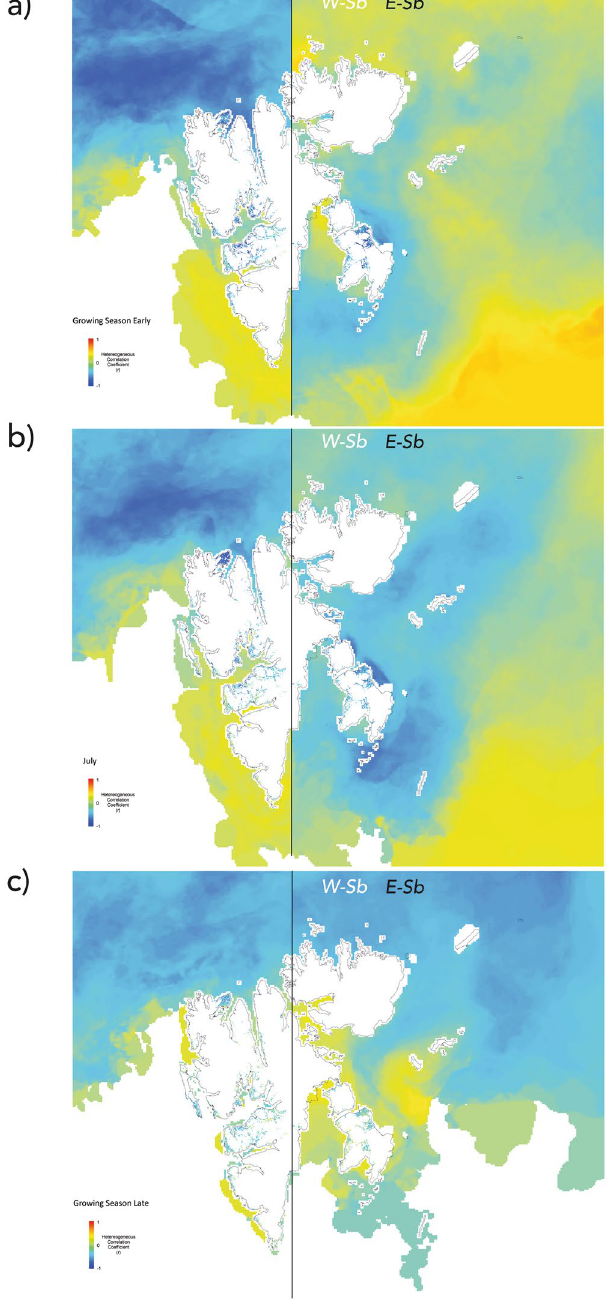
Figure 1. Heterogeneous Correlation Maps. Heterogeneous Correlation Maps between sea ice concentration and Normalised Difference Vegetation Index ( NDVI ) anomalies for the 1 st Singular Value ( SV ) during ( a ) the Early Growing Season ( EGS ; June 10 – July 4); ( b ) the Peak of Growing Season ( JL ; June 26 – August 5); and ( c ) the Late Growing Season ( LGS ; August 5 – September 6, see Methods) for the West ( left panel ) and East ( right panel ) halves of the Svalbard Archipelago. Land pixels show the correlation between observed NDVI (period 2000–2014) and the expansion coefficients of Sea Ice for the 1 st SV ; Ocean pixels show the correlation between observed Sea Ice concentration (period 2000–2014) and the expansion coefficients of NDVI for the 1 st SV . Maps were generated using Matlab (version R2016b; https://www.mathworks.com) and ArcMap (version 10.2; https:// www.esri.com), used herein under